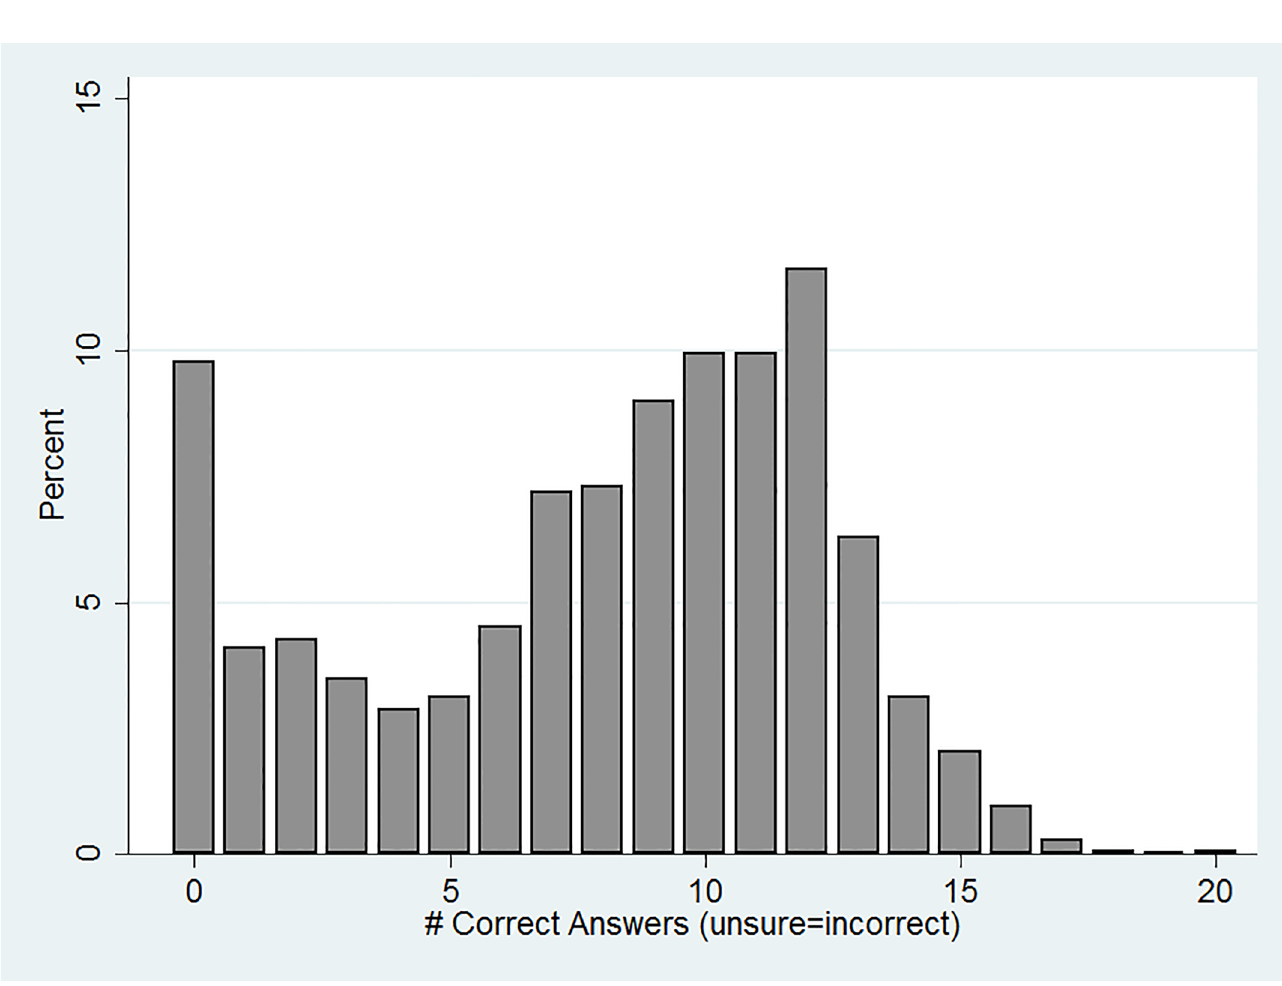
Fig 1. Distribution of Scores on ACA Preventive Service Knowledge Index. This figure shows the distributionof scores on the ACA Preventive Service Knowledge Index (N = 2990).